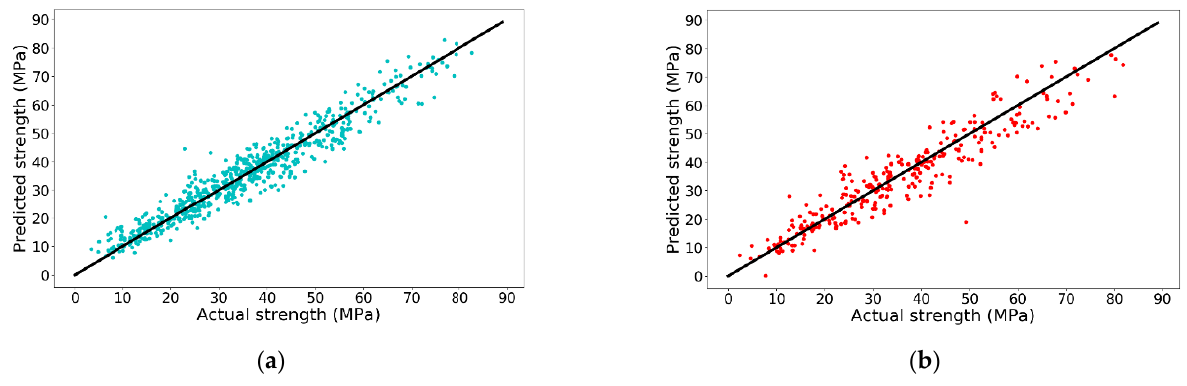
Figure 3. Prediction accuracy of 3rd degree polynomial LR model on ( a ) training set and ( b ) test set.